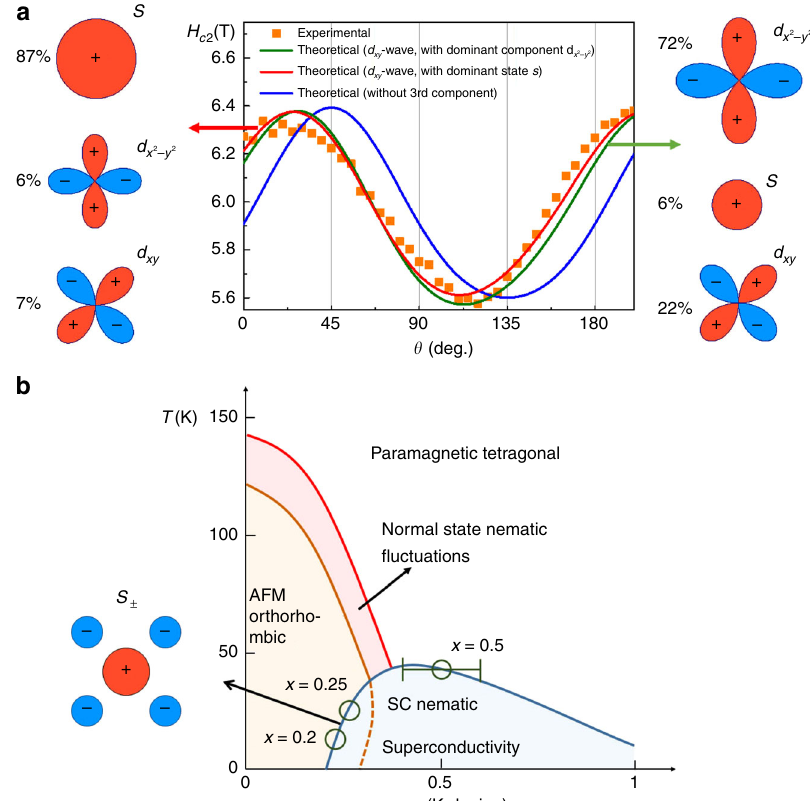
Fig. 4 Upper critical fi elds and phase diagram. a Angular dependence of the second magnetic critical fi eld at 38.4 K ( T c ≈ 39 K), retrieved from transport experiments (black fi lled square symbol) in the Corbino disc measurement con fi guration, from theoretical model with s -wave and d x 2 (cid:1) y 2 -wave symmetries (full blue line), from theoretical model with s ± -wave, d x 2 (cid:1) y 2 -wave and d xy -wave symmetries (full red and blue lines depending on dominant component). The mixing of the different symmetry components of the order parameters is indicated on the left and right side panels next to a schematic representation of each component of the order parameter as function of the internal momentum of the Cooper pairs. The indicated percentages correspond to the relative weights ( r 1 , r 2 , and r 3 ) of the wave function coef fi cients, Φ k ð Þ ¼ r 1 Φ s k ð Þ þ r 2 Φ d k ð Þ þ r 3 Φ d k ð Þ . In this schematic representation red and green indicate xy x 2 (cid:1) y 2 positive and negative value of the components, respectively. b Phase diagram of hole-doped Ba 1 − x K x Fe 2 As 2 iron-based superconductors. There is controversial evidence concerning the symmetry of the order parameter in the doping domain close to x = 1: refs. 12 – 14 argue in favor of s ± and ref. 11